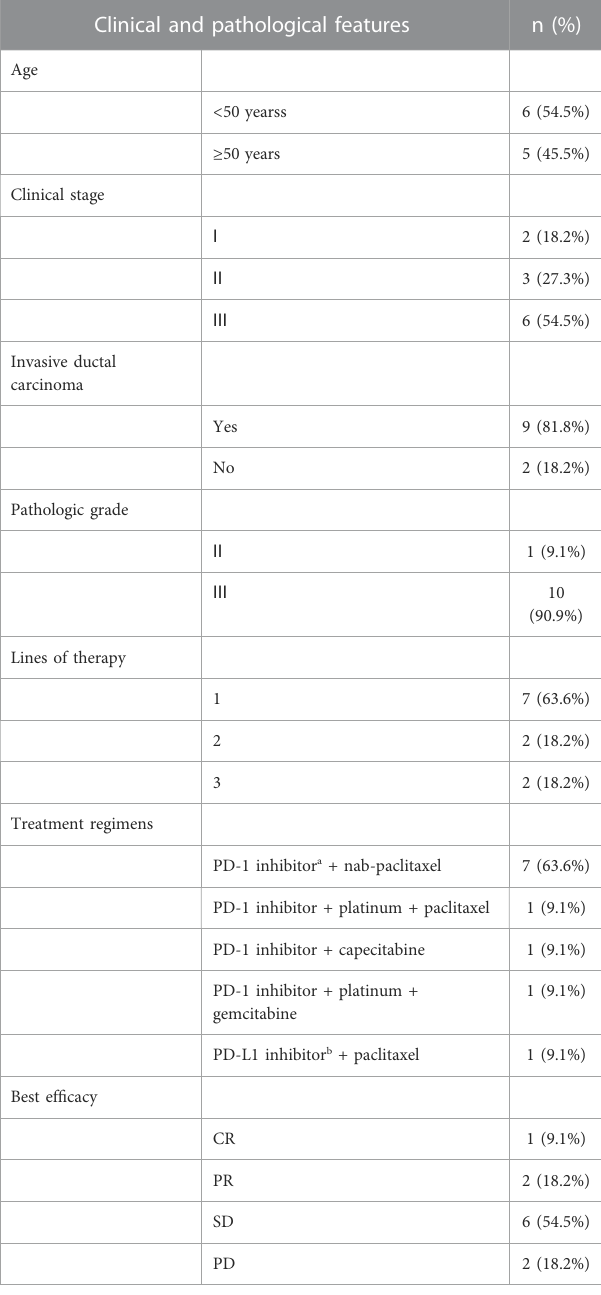
TABLE 1 Clinical and pathological features of enrolled patients (N = 11). Clinical and pathological